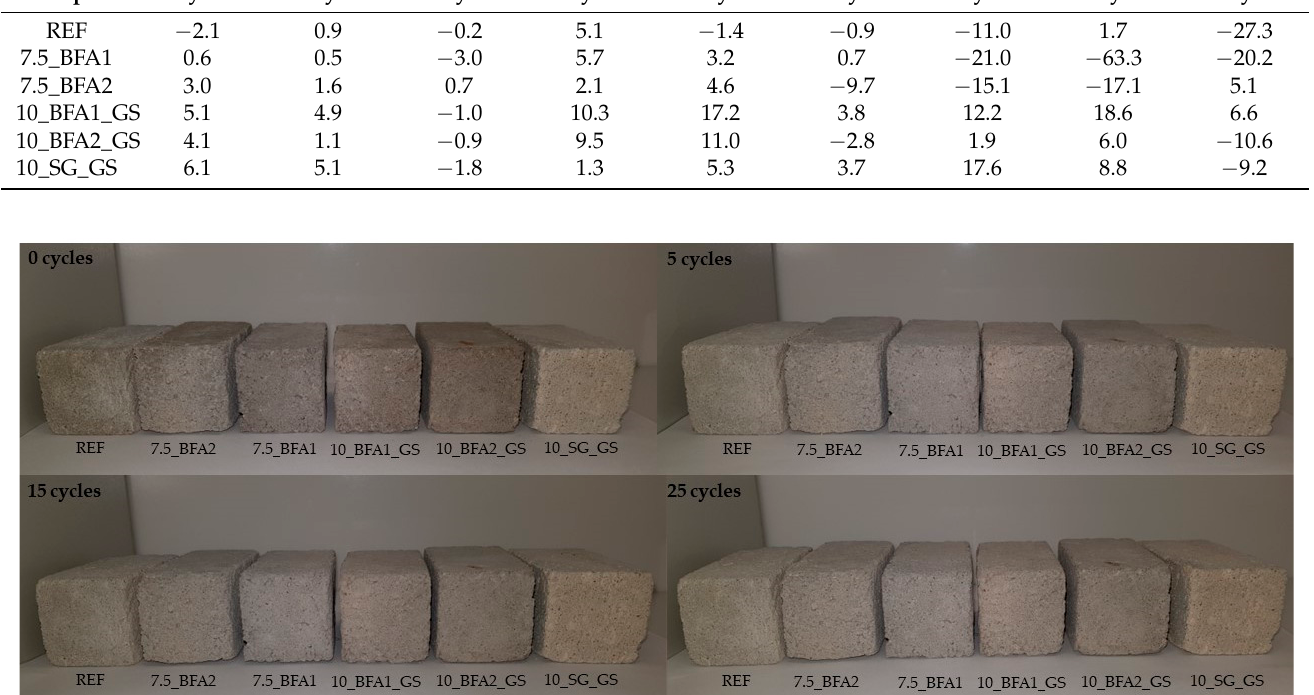
Figure 8. Sample images after 0, 5, 15 and 25 freeze-thaw cycles.